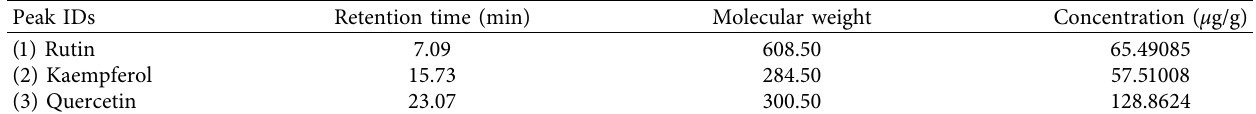
Table 2: LC-MS chromatogram of Atrifil extract and Oshagh